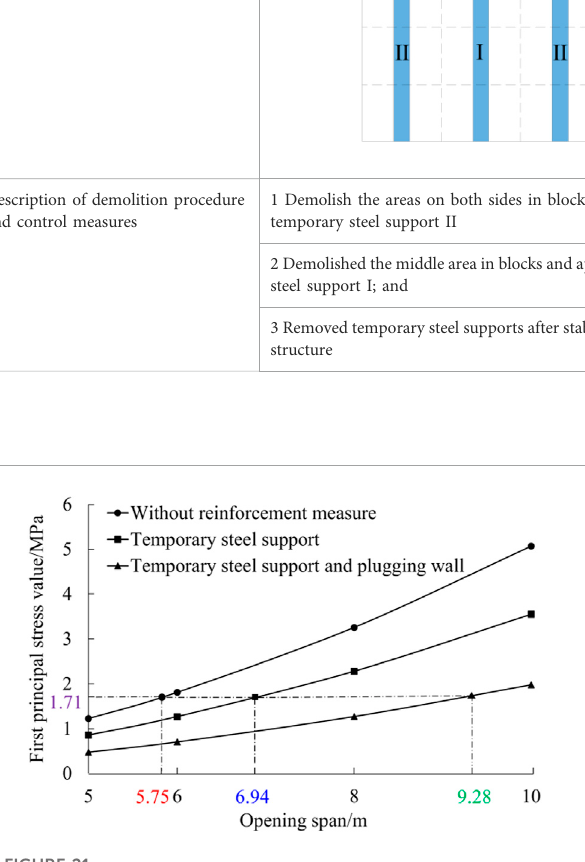
FIGURE 21 Ultimate opening span under different reinforcement measures.